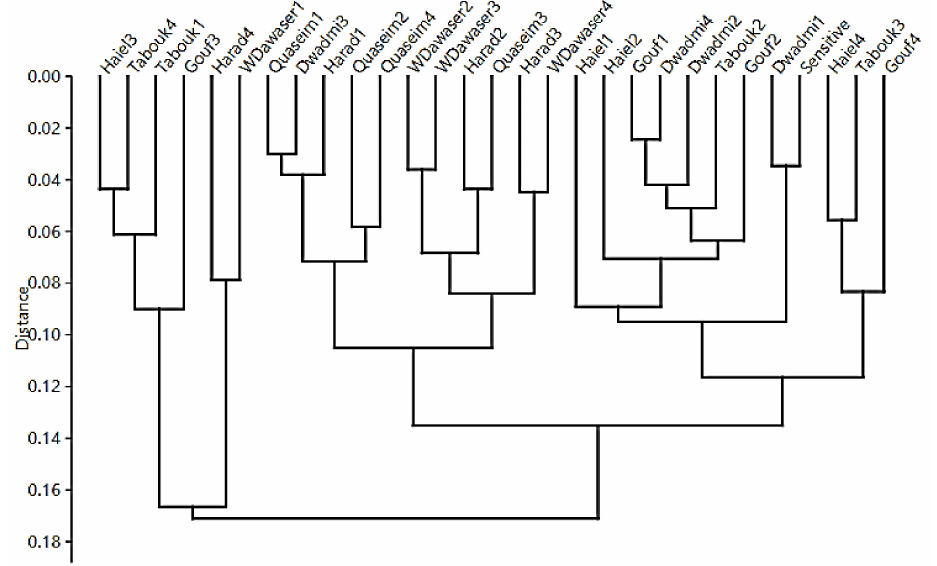
Figure 2. Cluster analysis based on morphological Lolium studied traits using PAST